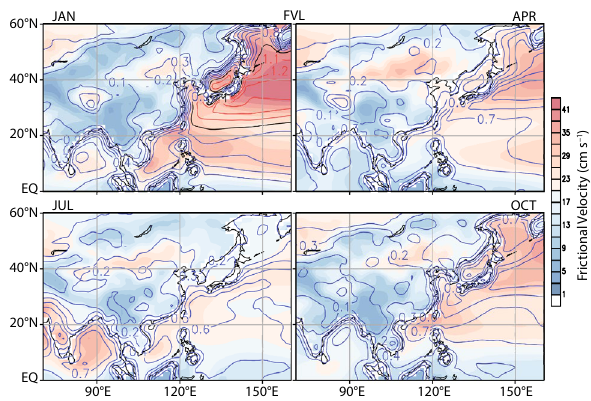
Fig. 3 The patterns of frictional velocity (shade; cm s –1 ) together with the minimum boundary layer height (blue contours < 1.0 (black) < red contours at 0.1 km interval) for the diurnal/seasonal cycle mode